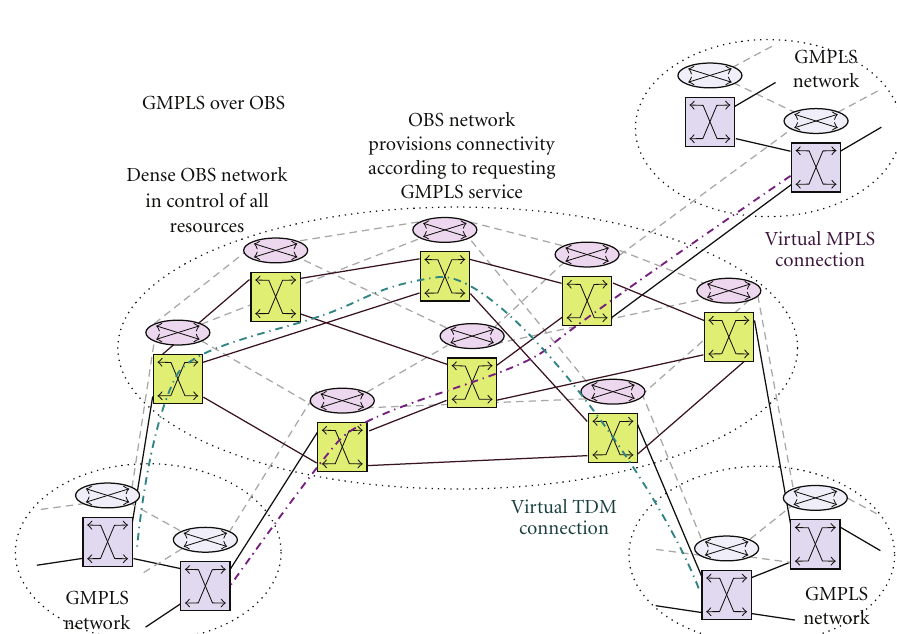
Figure 14: OBS network as client of a GMPLS-controlled infrastructure.